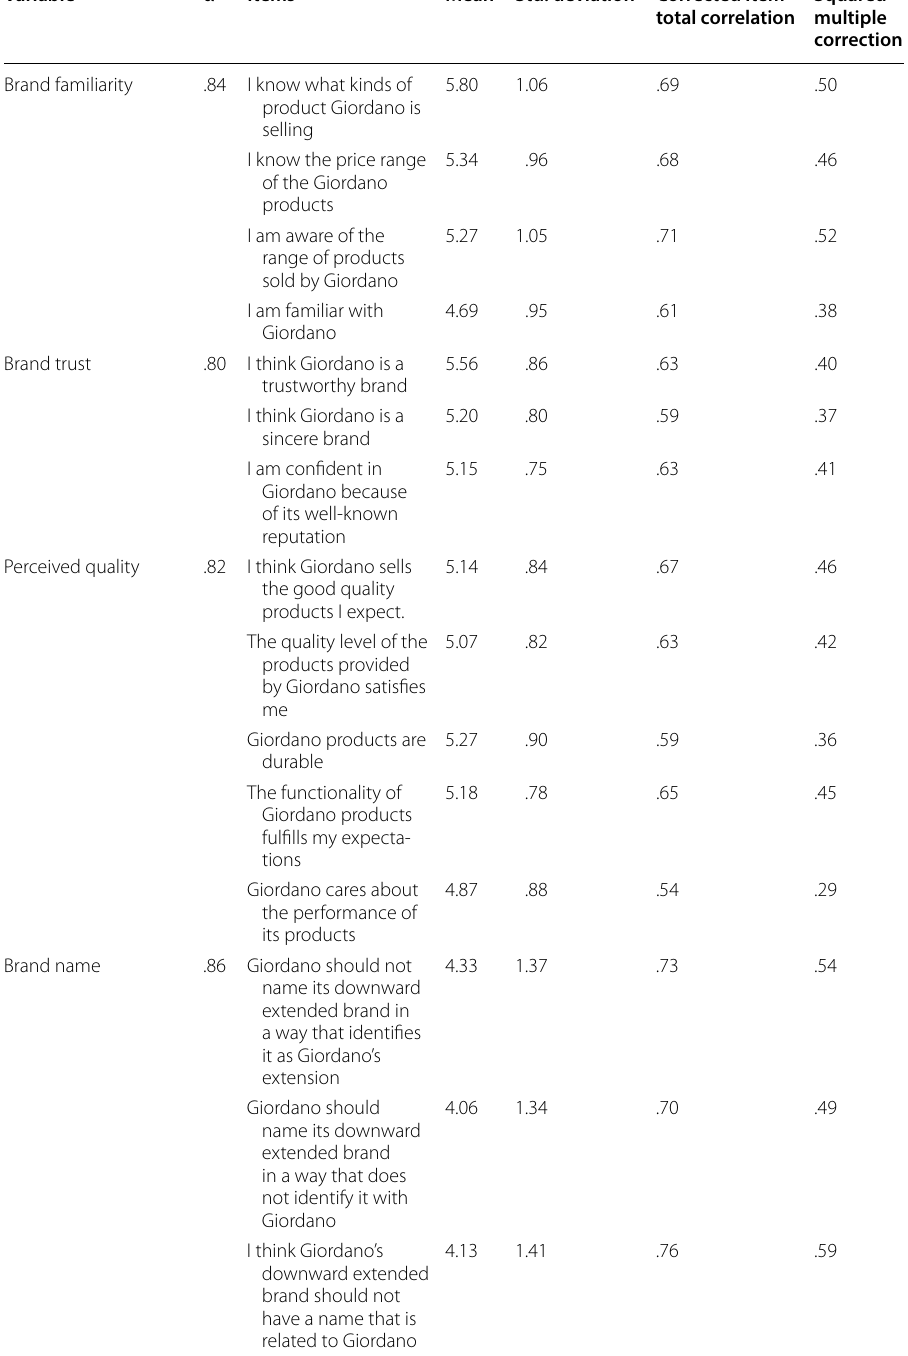
Table 2 Results of the reliability testing of the items Variable α Items Mean Std. deviation Corrected item-